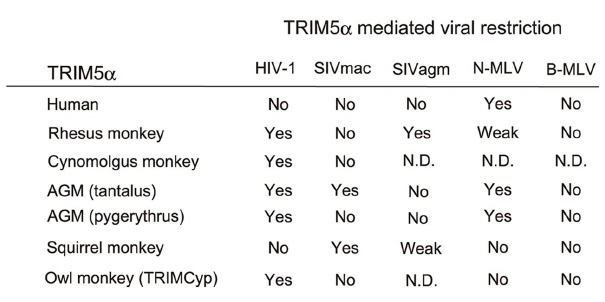
FIGURE 3 | Species-specific restriction byTRIM5 α . “Yes” denotes restriction. “Weak” denotes weak restriction. “No” denotes no restriction. “N. D.” denotes no result has yet been published. SIVmac, simian immunodeficiency virus isolated from a macaque (Ohkura et al., 2006). SIVagm, simian immunodeficiency virus isolated from an African green monkey (Song et al., 2005b). N-MLV, N-tropic murine leukemia virus (Ohkura et al., 2006); B-MLV, B-tropic murine leukemia virus (Ohkura et al., 2006). AGM, African green monkey (Nakayama et al., 2005; Kim et al., 2011). Rhesus monkey (Stremlau et al., 2004;Ylinen et al., 2005; Ohkura et al., 2006), cynomolgus monkey (Nakayama et al., 2005), and owl monkey TRIMCyp (Nisole et al., 2004; Sayah et al., 2004) are also